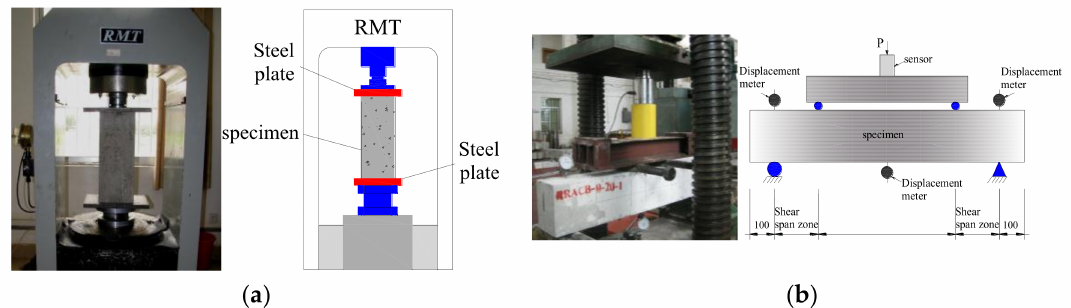
Figure 4. Loading installation. ( a ) Loading installation for block and column; ( b ) Loading installation for